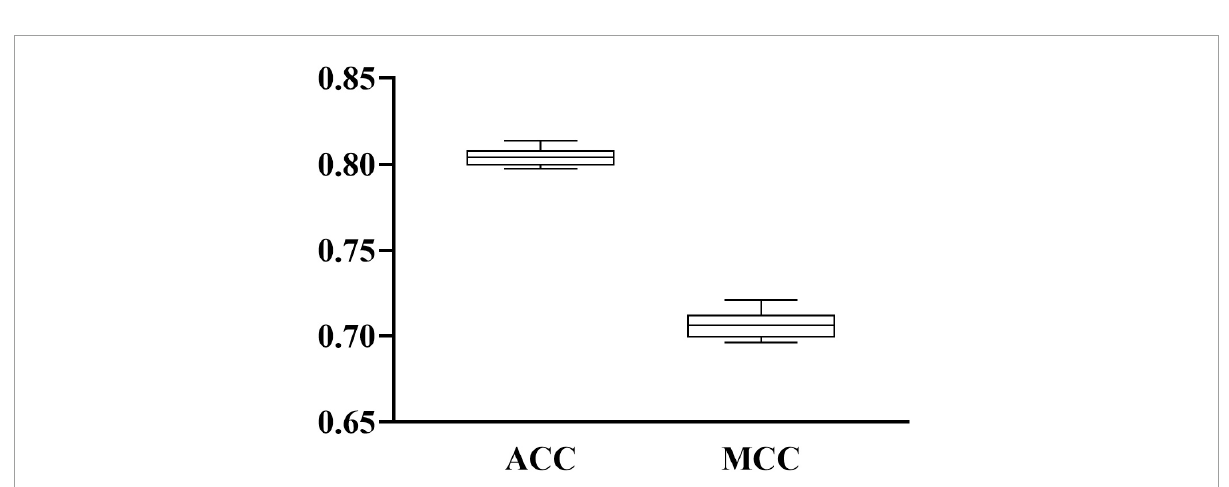
FIGURE5 Box plot to show the performance of RF classifier with top 120 features under 10-fold cross-validation for 10 times. ACC and MCC vary in a small range, indicating the stability of the